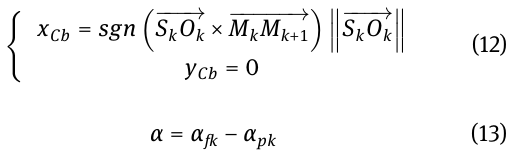
angle α in Figure 15 can be calculate in the following